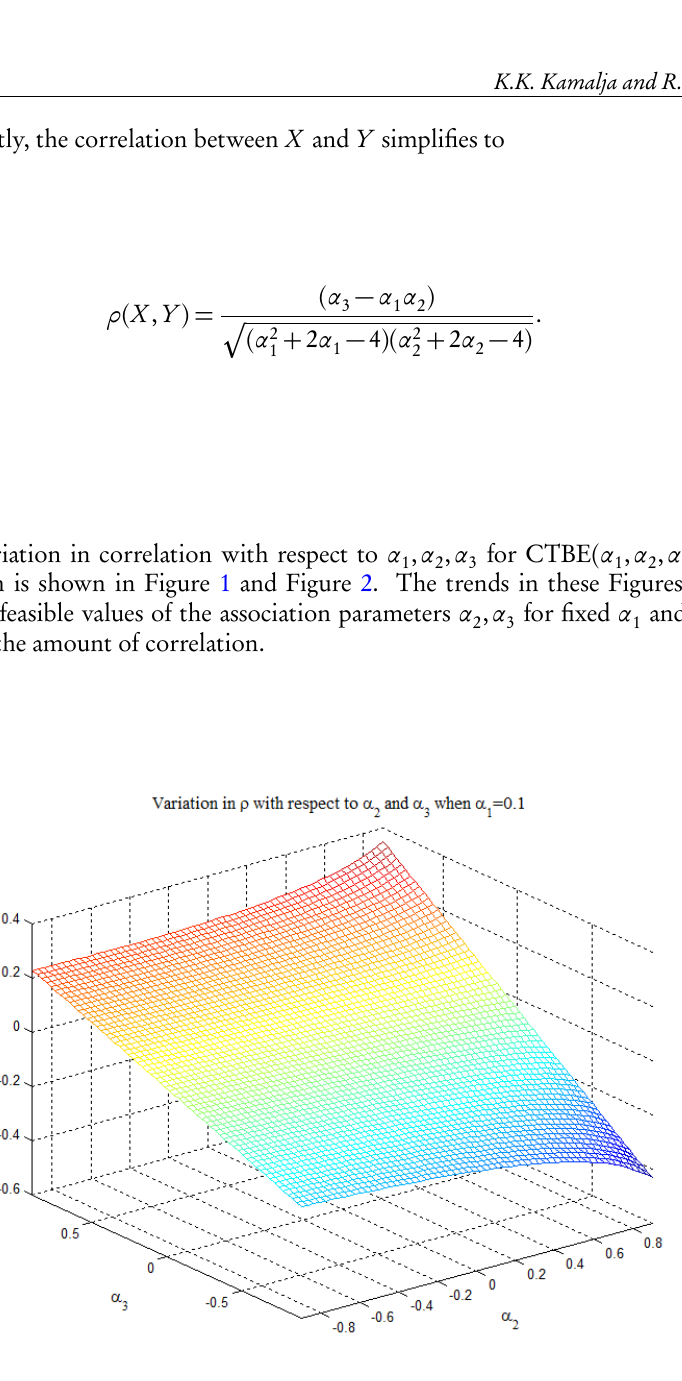
, α for CTBE ( 0.1, α 2 3